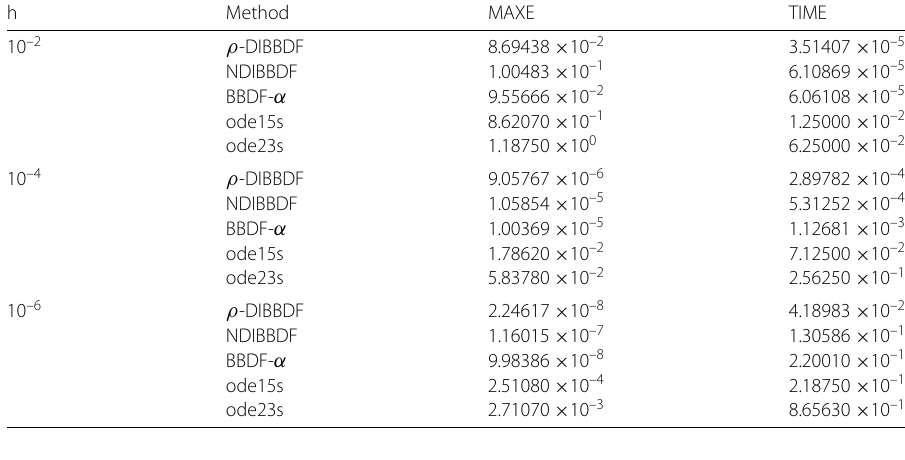
Table 8 Numerical results for concentration of drug in Model C(i) h